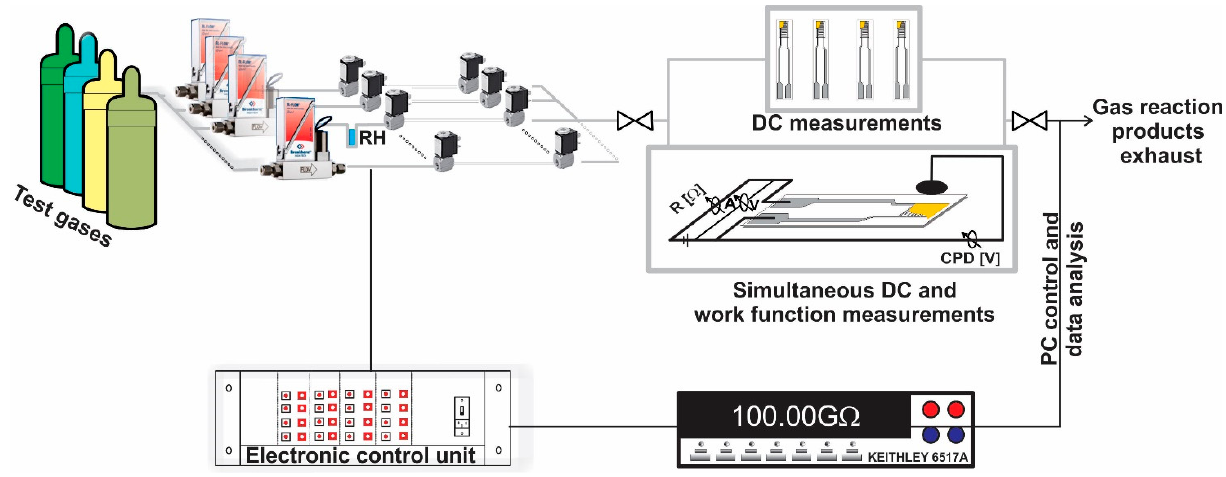
Figure 1. Gas mixing station with accessories for the metal oxide semiconductors (MOX) gas sensors evaluation.